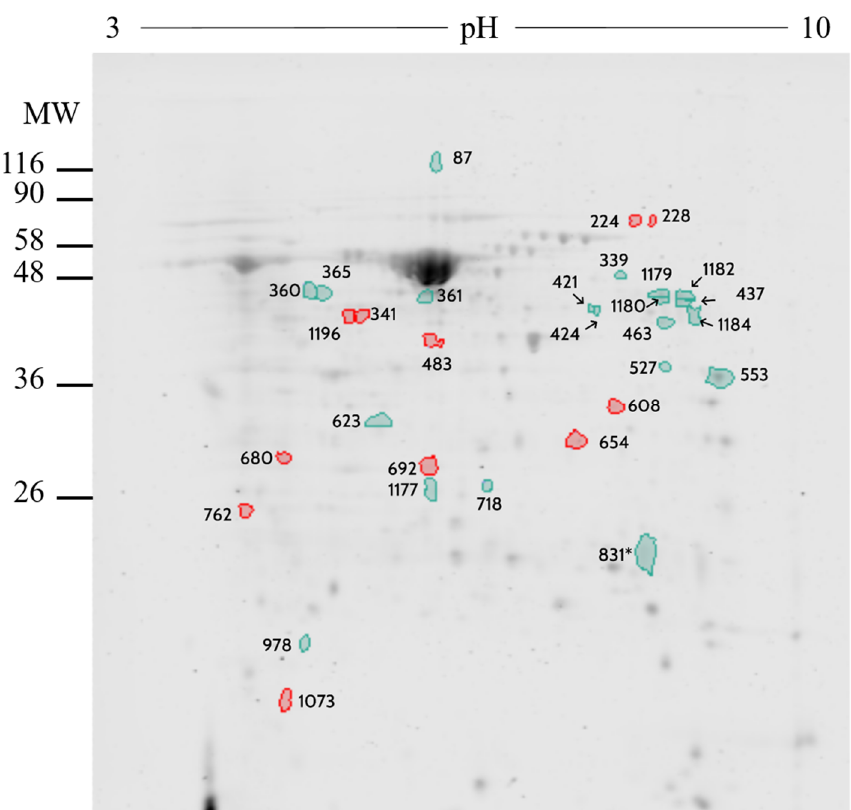
Figure 3. 2D gel electrophoresis comparing oviduct fluid from isthmus between pregnant vs. cyclic heifers. Resolution of 150 µg of oviduct fluid in Maxi gel with non-linear gradient strips of pH 3–10 stained with Coomassie Blue. Image analysis was performed with SameSpots v.4.0 software. Spots marked in green correspond to the proteins more abundant in pregnant heifers, while spots marked in red were more abundant in cyclic heifers. MW: molecular weight. Table 2. Proteins identified by MS/MS in the oviduct fluid from isthmus of pregnant vs. cyclic heifers.